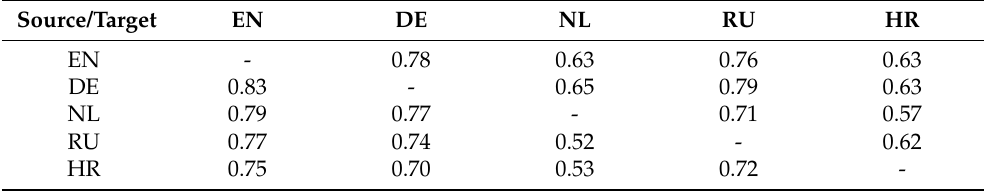
Table A7. Spearman’s correlation coefficients for multilingual BERT model, 1000-word